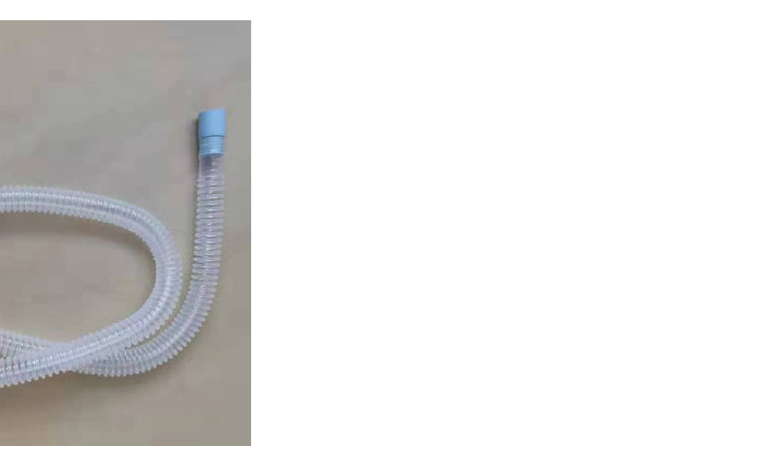
Figure 3. Carina disposable non-invasive tube with a leaking valve (MP00312, Ventstar Carina LeakV, Drager, Canada), in our study, we only cut and use the leaking valve (red arrow).